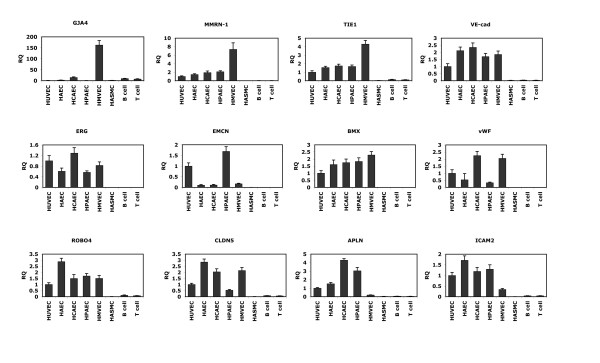
Validation of a selected subset of endothelial-restricted genes by quantitative RT-PCR. Validation of a subset of EC-restricted genes from Table 1 was conducted using primary ECs and non-ECs by quantitative RT-PCR (n = 3 per cell type). The gene symbol is listed for each gene. RQ refers to "relative quantity" where the expression in HUVECs has been set to 1.0 and the relative expression of the other cell types are compared to that in HUVECs.